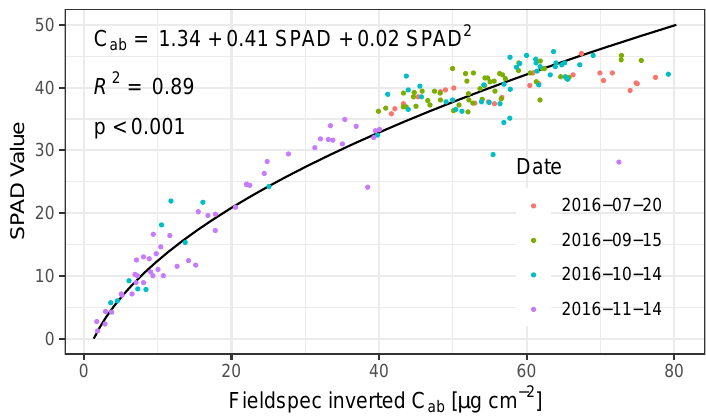
Figure A1. Comparison of Fieldspec inverted C ab with SPAD meter value taken from the same leaf samples. Solid line, R 2 , p -value and formula correspond to the quadratic fit. Dates correspond to the leaf sampling